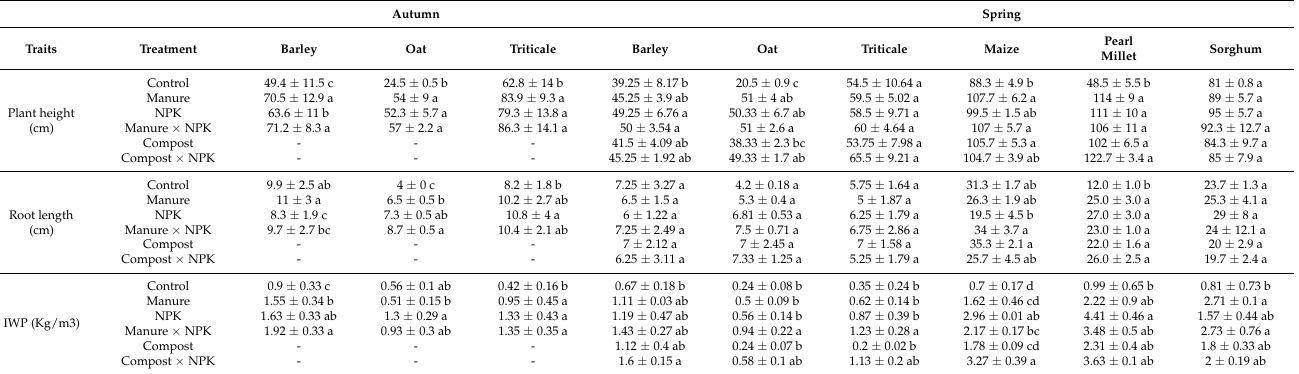
Table 1. Effect of organic amendments and NPK fertilizers on plant height, root length, and irrigation water productivity (IWP) of different crops planted during autumn and spring seasons. Results presented are means ± standard deviation. Means sharing same letters do not differ significantly at p = 0.05.